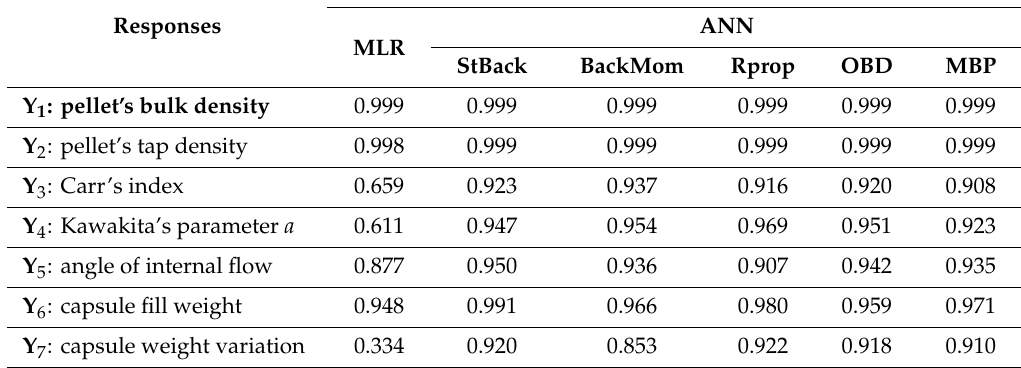
Table 6. Predictive ability (R 2 index) of the MLR and the original ANN models trained by the StBack, BackMom, or Rprop, and the pruned (OBD and MBP) networks, and results of the external data set (Table